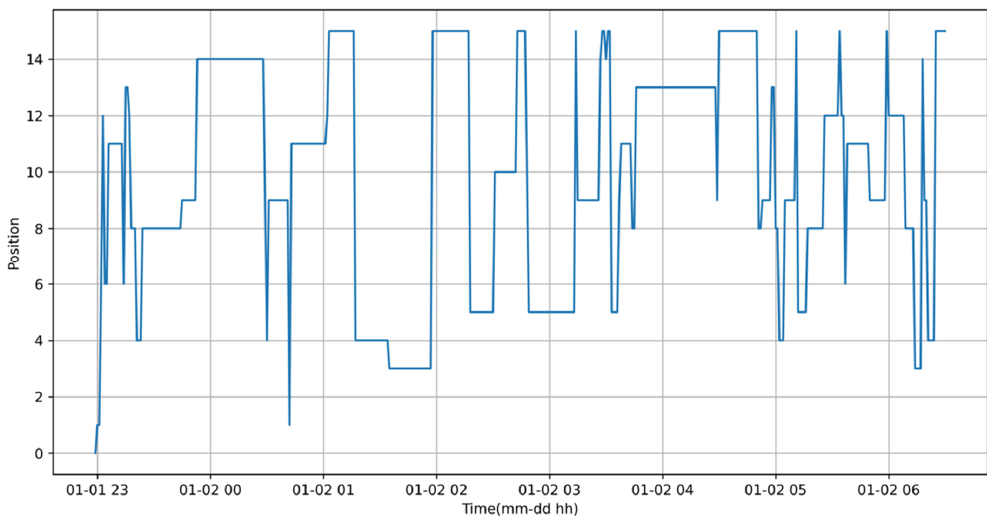
Figure 15. The distribution of the head position for user1.